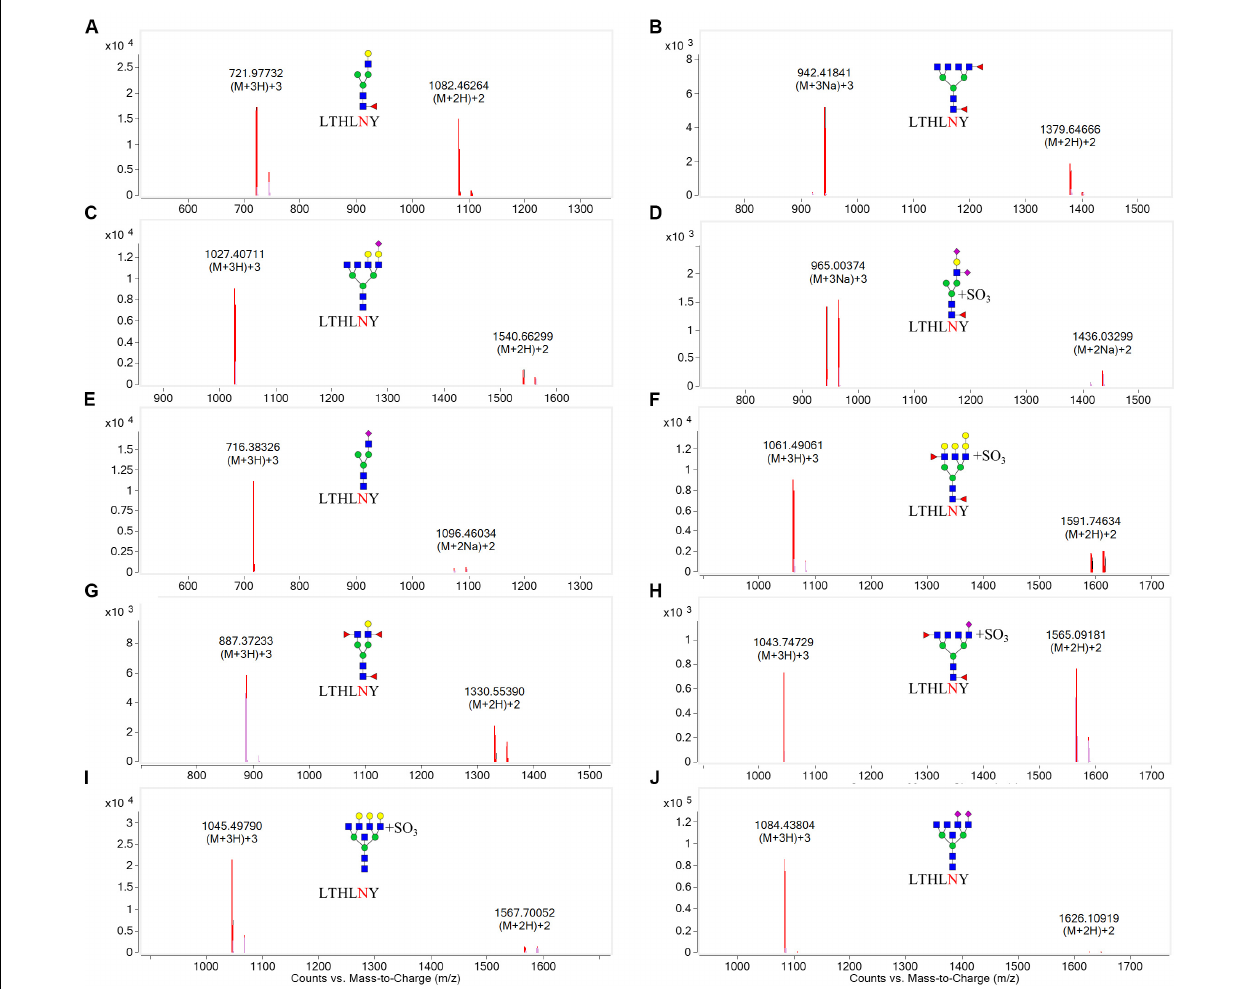
FIGURE 7 | Overlaid extracted compound chromatograms (ECCs) of identified HA1 glycopeptides containing the glycosylation site at position 158. HA1 proteins extracted from influenza were digested with chymotrypsin at 25 ◦ C for 16 h, followed by profiling the glycopeptides by C18 chip-Q-TOF-MS. The glycoforms at position 158 were then identified based on high-resolution MS data. (A) : 4_3_1_0, (B) : 3_6_2_0, (C) : 5_6_0_1, (D) : 4_3_1_2 (SO3), (E) : 3_3_0_1, (F) : 7_5_2_0 (SO3), (G) : 4_4_3_0, (H) : 3_6_2_1 (SO3), (I) : 6_7_0_0 (SO3), (J) :